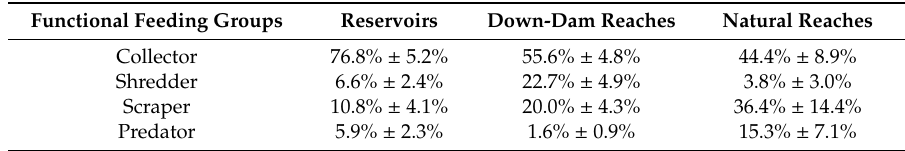
Table 4. Percentage (Mean ± SD) of di ff erent functional feeding groups of macroinvertebrates in the NR reservoir, down-dam reaches, and natural reaches.